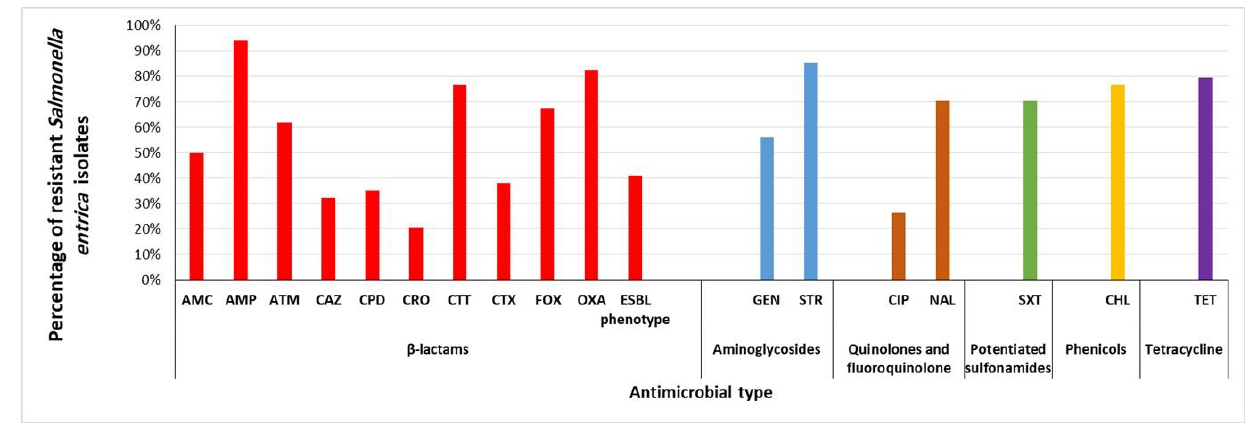
Figure 2. Resistance phenotypes of Salmonella enterica isolated from retail chicken meat, beef meat, and beef carcasses in Egypt. AMC, amoxicillin-clavulanic acid; AMP, ampicillin; ATM, aztreonam; CHL, chloramphenicol; CIP, ciprofloxacin; CAZ, ceftazidime; CPD, cefpodoxime; CRO, ceftriaxone; CTT, cefotetan; CTX, cefotaxime; ESBL, extended-spectrum β-lactamase; FOX, cefoxitin; GEN, gentamicin; NAL, nalidixic acid; OXA, oxacillin; STR, streptomycin; SXT, sulfamethoxazole-trimethoprim; TET, tetracycline. Table 1. Resistance phenotypes and incidence of resistance genes in Salmonella enterica isolated from retail meats and beef carcasses in Egypt.